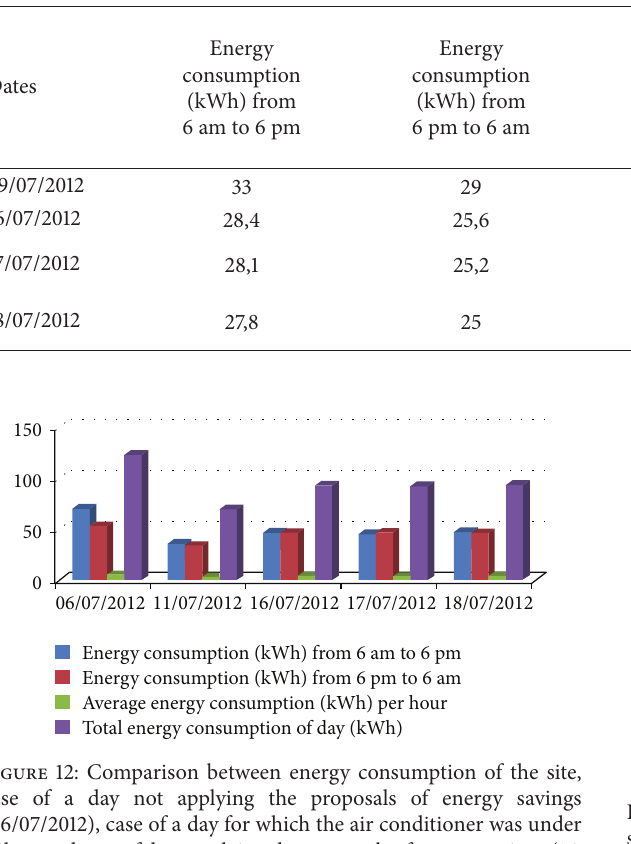
3240 kWh/year, or 14.5% of energy saving realizable . In terms of saving costs, it is 45,84 USD/month or 550,10